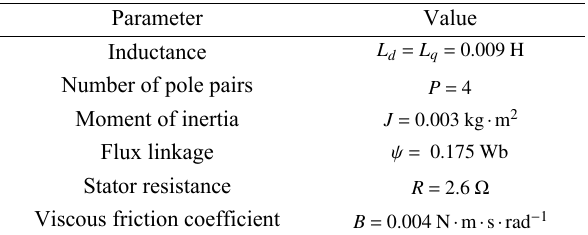
Table 1 PMSM parameters specification.